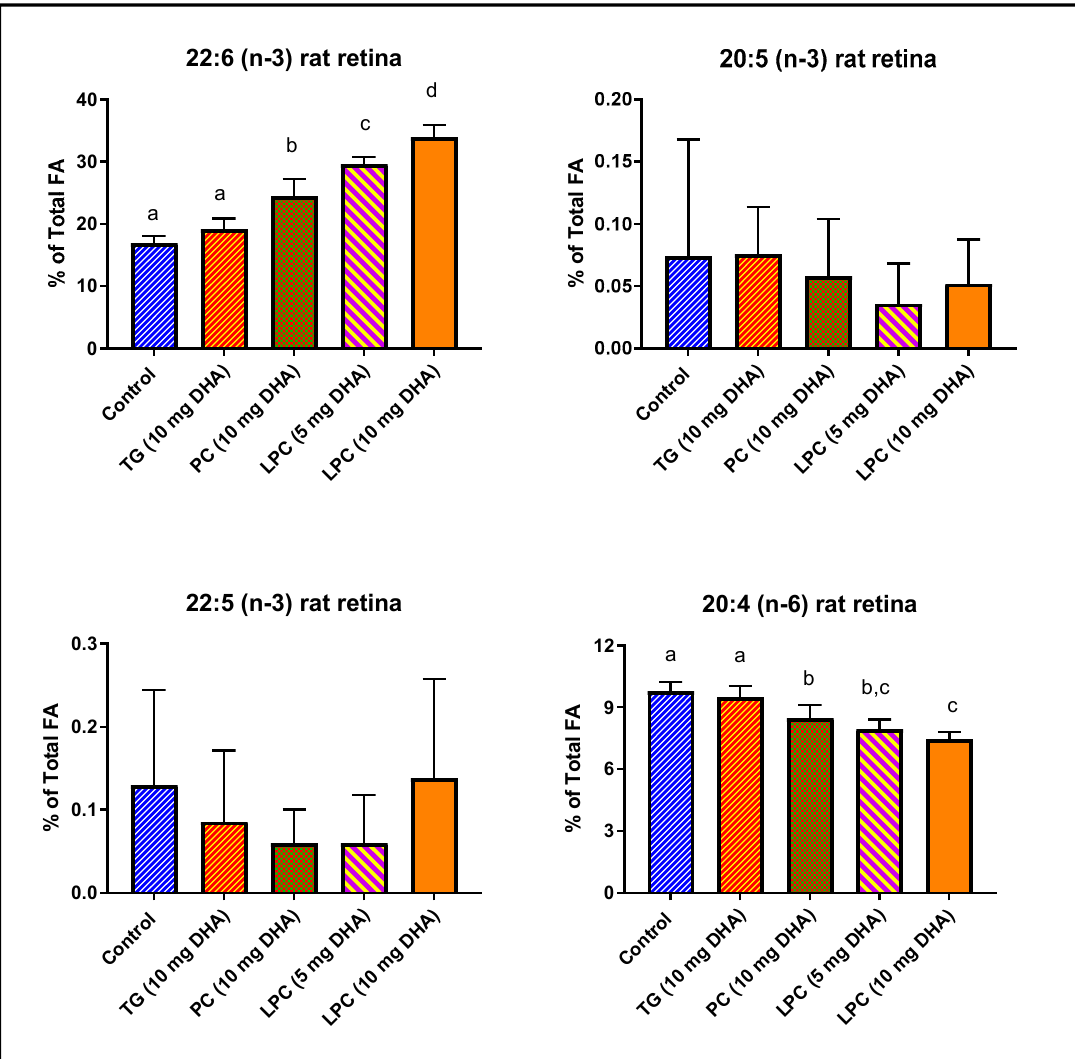
Figure 1. Incorporation of dietary DHA fed in the form of PC, TAG, or LPC into rat retinal lipids. Normal male Sprague-Dawley rats (8-week-old; n = 5 per group) were gavaged daily with 10 mg DHA in 250 µL corn oil in the form of TAG-DHA, di-DHA PC, or LPC-DHA for 30 days. In addition, a half-dose of LPC-DHA (5 mg DHA) was used to be comparable to the amount of LPC-DHA expected to be generated by di-DHA PC during digestion. All animals were on regular rodent chow that contained no DHA, but contained 17.4 mg α -linolenic acid (18:3, n-3) per g of chow. Retinal FA were analyzed by GC/MS as described in the text. The percent composition of 20:4 (n-6), 20:5 (n-3), 22:5 (n-3), and 22:6 (n-3) are shown here. The total FA composition is shown in Table 1. The significance of differences between the treatment groups was determined by a one-way ANOVA, with Tukey multiple post-hoc test (Graphpad Prism 8.0). Bars without common superscripts are significantly different from each other ( p < 0.05). TG: triacylglycerol; PC: phosphatidylcholine; LPC: lysophosphatidylcholine; FA: fatty acid; GC/MS: gas chromatography/mass spectroscopy.